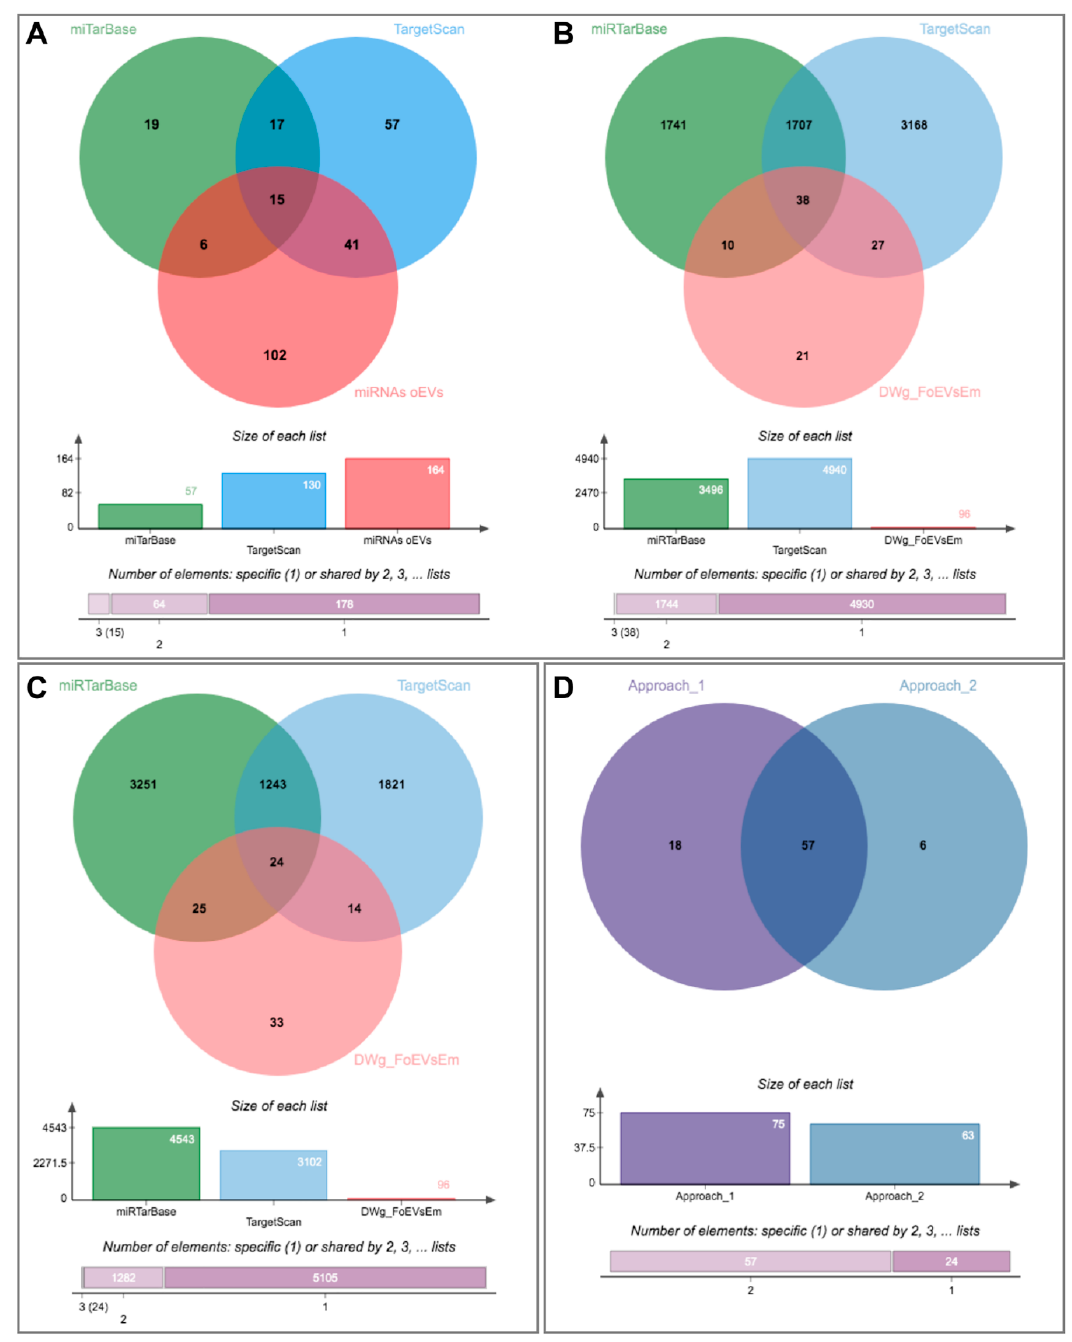
Figure 6. Identification of potential miRNAs in oviductal EVs responsible for downregulation of embryo gene expression using two different approaches: (1) From identified downregulated genes in embryos to potential miRNAs in oEVs and (2) From identified miRNAs in oEVs to potential target genes in embryos. ( A ) Venn diagram representing the comparison among potential miRNAs targeting identified downregulated genes in embryos using miTarBase and TargetScan databases and identified miRNAs in oEVs; ( B ) Venn diagram representing the comparison of potential target genes of the miRNAs derived from the previous comparison and identified downregulated genes in embryos; ( C ) Venn diagram representing the comparison among potential target genes derived from identified miRNAs in oEVs using miTarBase and TargetScan databases and identified downregulated genes in embryos; ( D ) comparison of lists of target genes from both approaches.